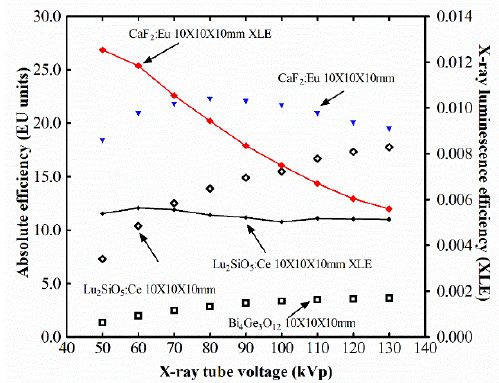
Figure 1. Absolute luminescence efficiency (AE) and X-ray luminescence efficiency (XLE) results for the 10 × 10 × 10 mm 3 CaF 2 :Eu crystals. Comparison of the AE results with published data for lutetium oxyorthosilicate (LSO) and bismuth germinate oxide (BGO).